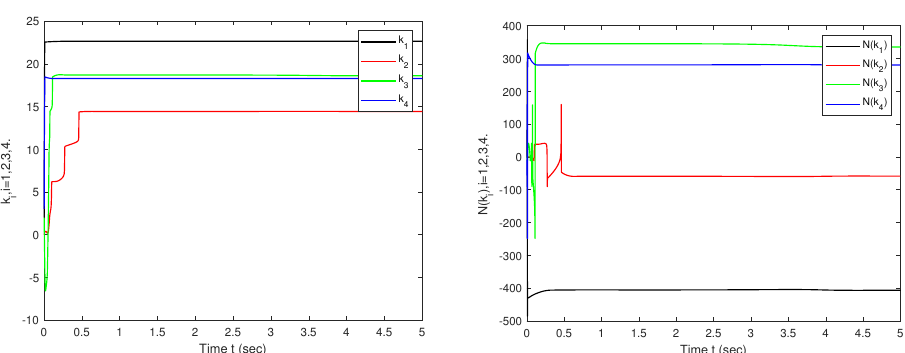
Figure 5. The variable k i and Nussbaum function N ( k i ) , i =